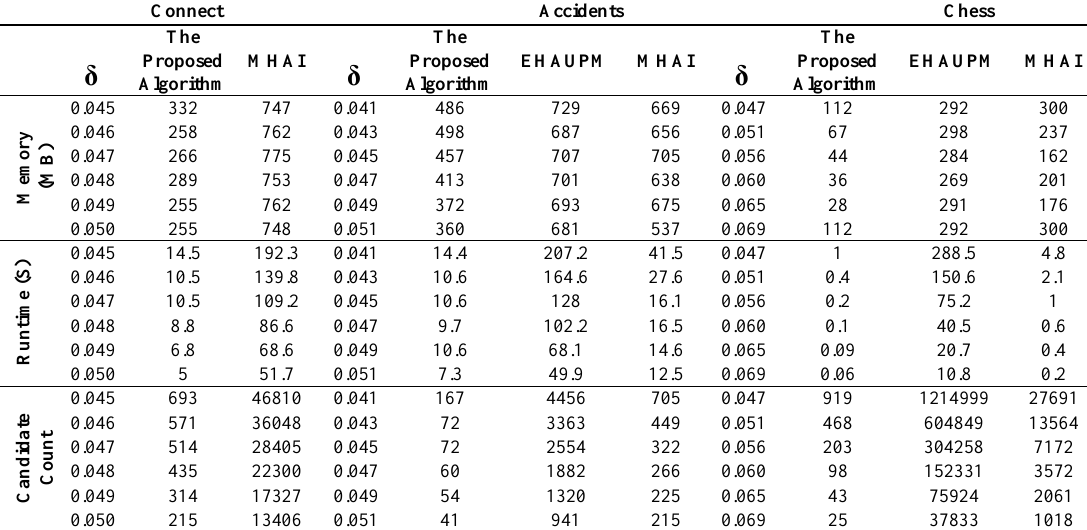
Figure 5. Memory consumption, runtime, and candidate count for various average utility Table 7. Memory consumption, runtime, and candidate count for various average utility thresholds.